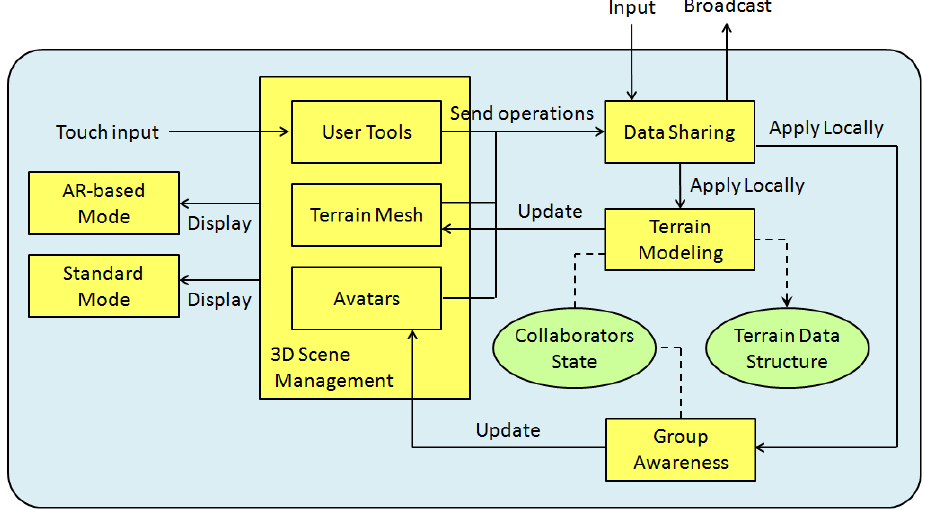
Figure 2. Functional and data components of the ShAREdT architecture.